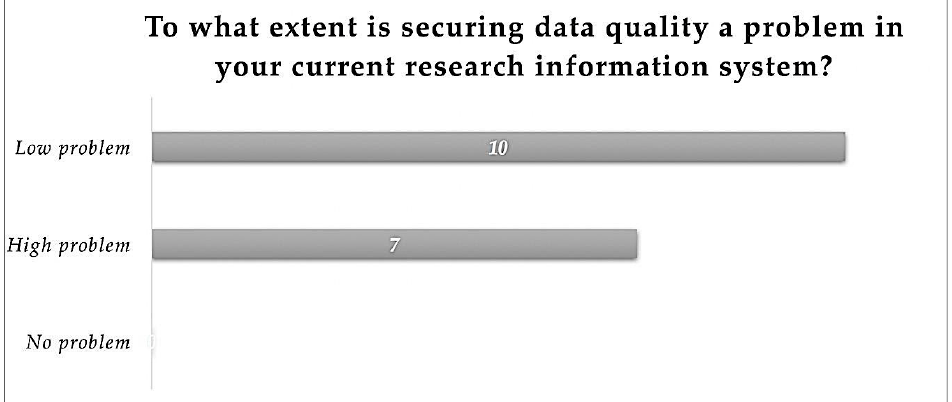
Figure 8. Securing data quality is a problem in CRIS ( N = 17 ).